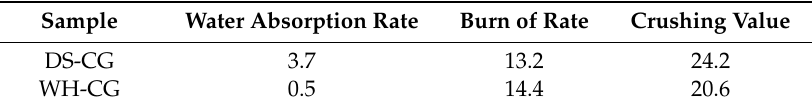
Table 4. Basic indexes of CG (%).